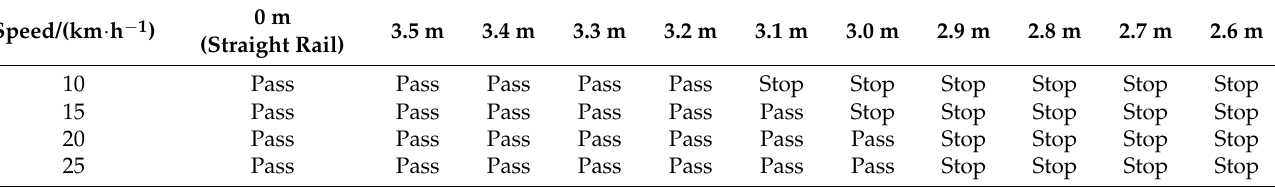
Table 1. Simulation experiment on straight and curved horizontal tracks.